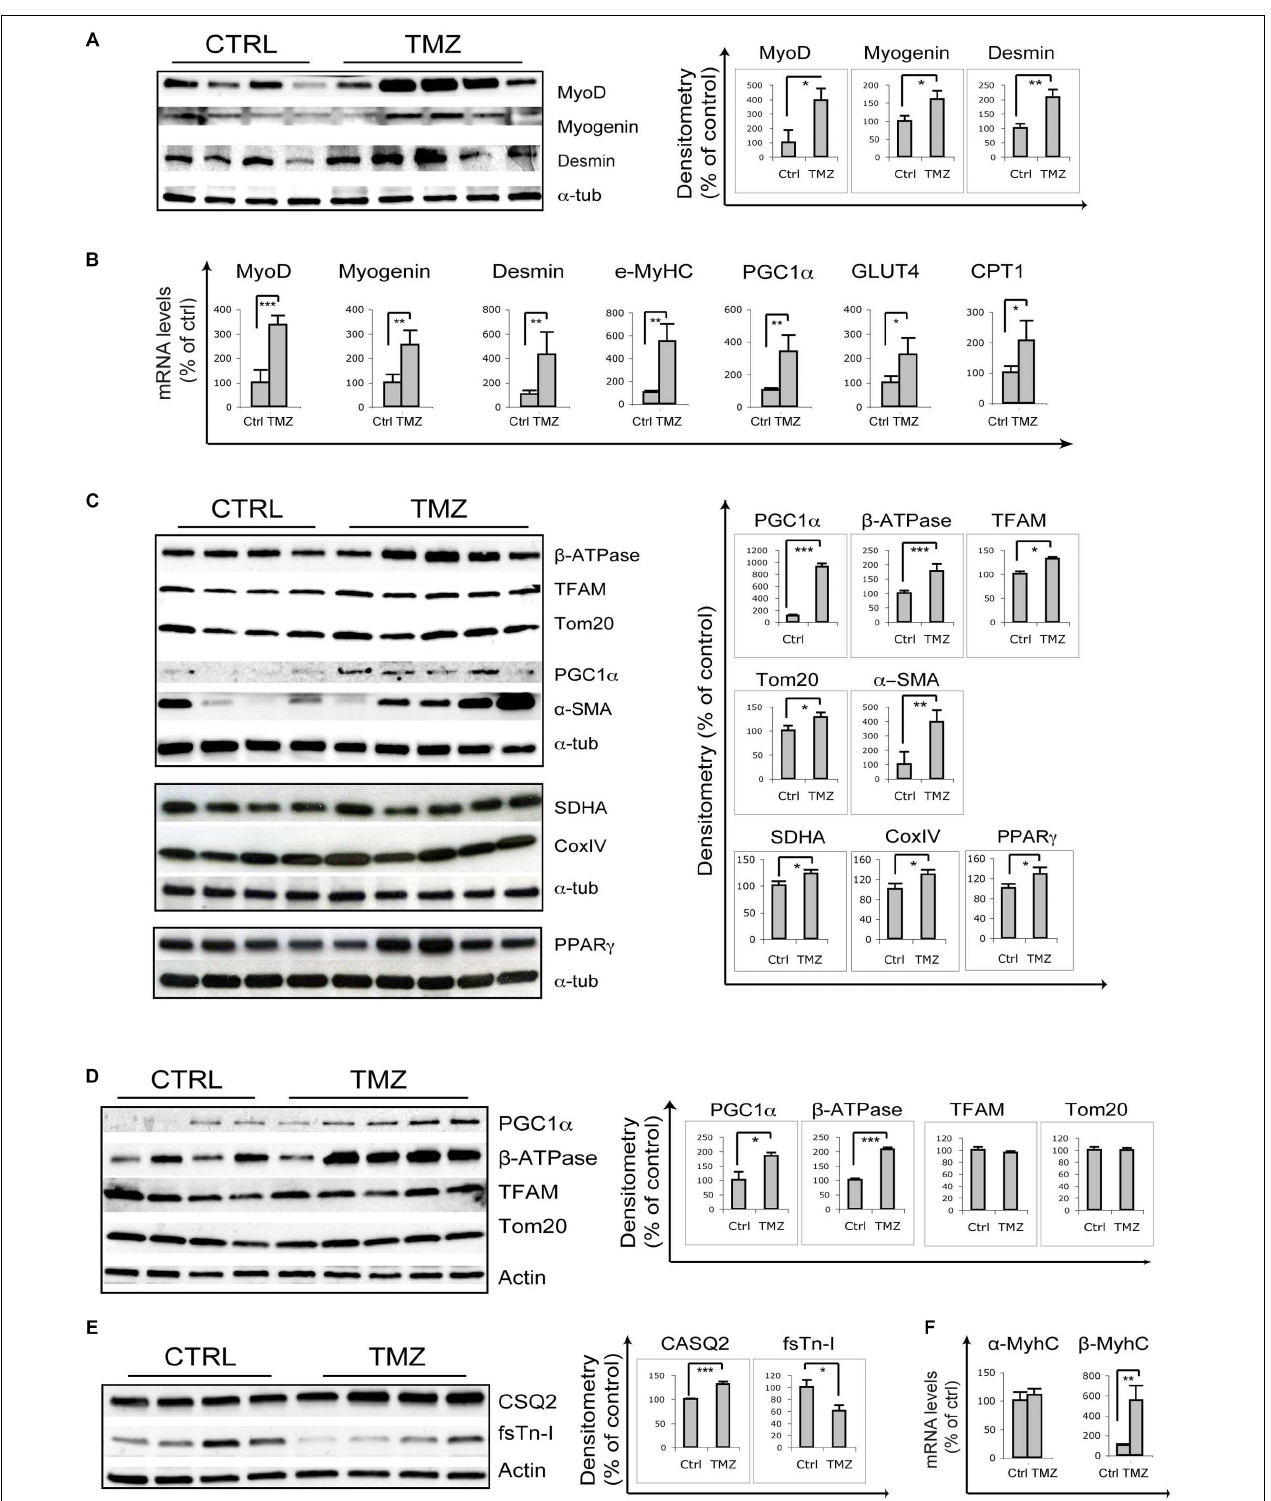
FIGURE 1 | Trimetazidine stimulates myogenic and mitochondrial gene expression. (A) Gastrocnemius extracts from untreated aged mice (Ctrl) and TMZ-treated aged mice (TMZ) were assayed for MyoD Myogenin and Desmin protein levels, (B) for the mRNA levels of MyoD, Myogenin, Desmin, MyHC, PGC1 α , GLUT4, and CPT1 which were evaluated by qRT-PCR, and (C) for β -ATPase, TFAM, Tom20, PGC1 α , and α -SMA protein levels. Protein levels of representative four out of six